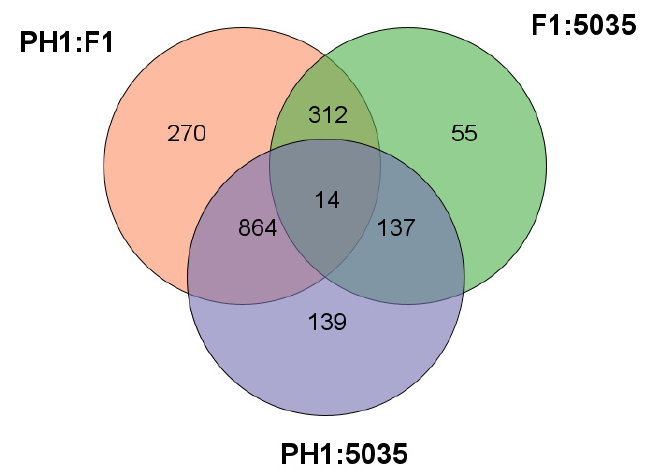
Figure 2. The intersections between DEGs identified through comparing each possible pair of F1, PH1, and 5035 strains are shown in Venn graph.